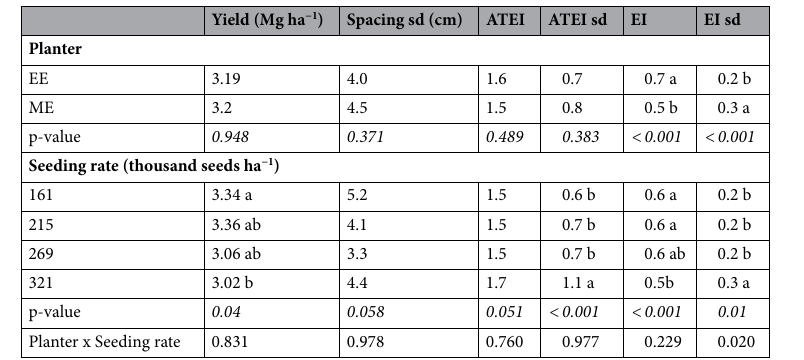
Table 2. Effect of planter type, seeding rate, and their interaction on yield and stand uniformity variables for all US studies. References: Spacing between plants standard deviation (Spacing sd), achieved versus targeted evenness index mean and standard deviation (ATEI and ATEI sd, respectively), and evenness index mean and standard deviation (EI and EI sd, respectively). 1 Planter type: Max Emerge (ME) and Exact Emerge (EE). 2 Letter and ANOVA threshold. Different letters mean significant differences among treatments. The values in italics correspond to the